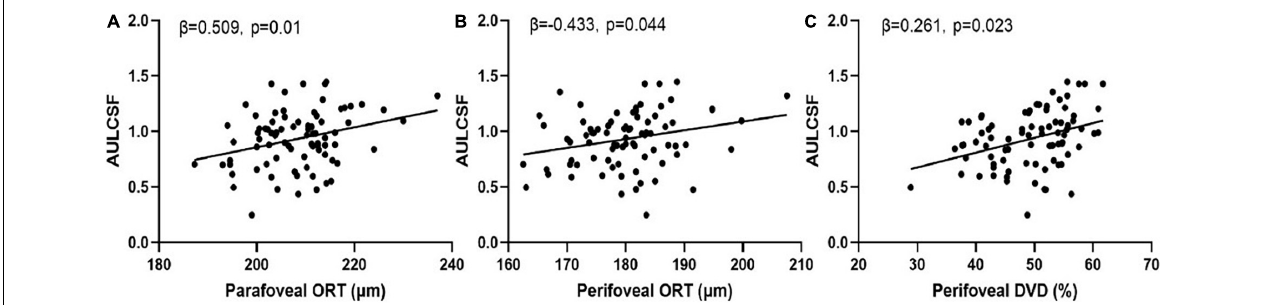
FIGURE 4 | Scatter plots of measures of chorioretinal structure and vasculature vs. AULCSF. (A) Parafoveal outer retinal thickness vs. AULCSF; (B) Perifoveal outer retinal thickness vs. AULCSF; (C) Perifoveal deep vascular density vs.